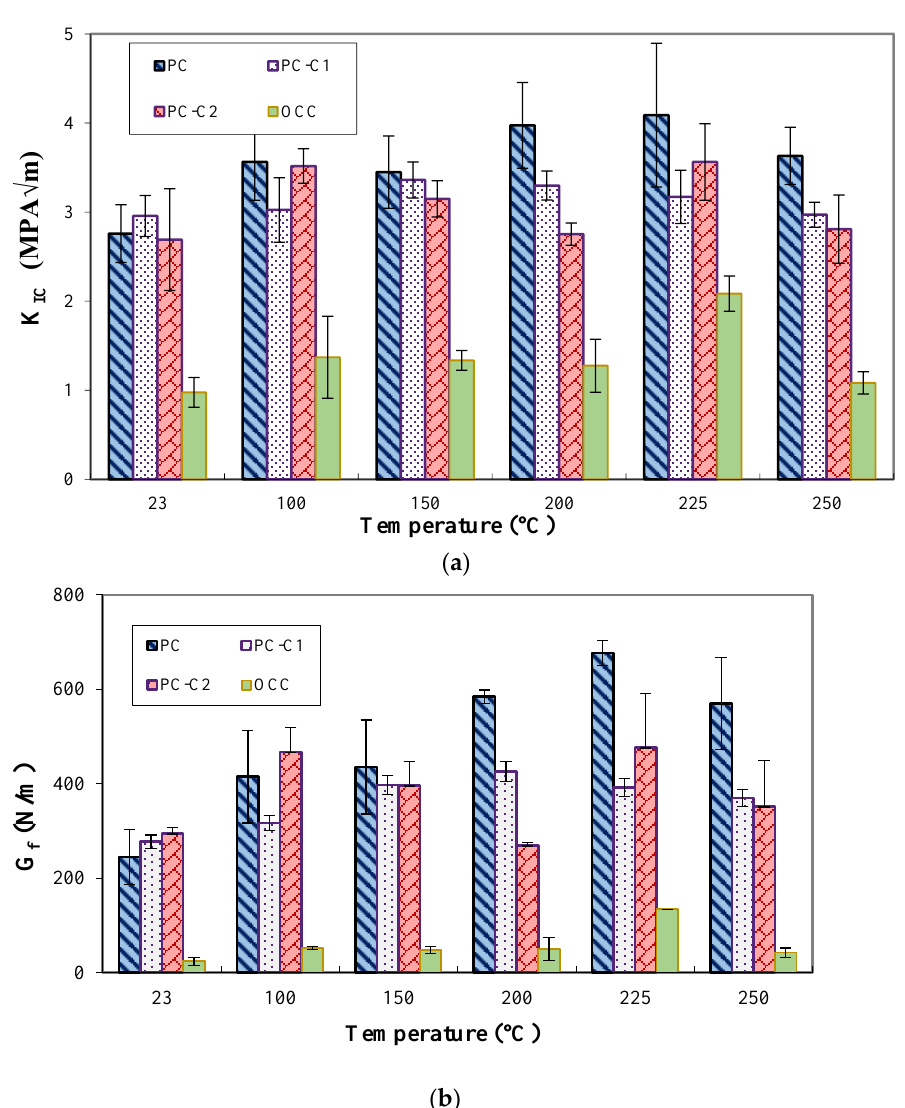
Figure 10. Fracture parameters as a function of heating temperature for concrete mixes. ( a ) Stress intensity factor ( b ) Fracture energy.